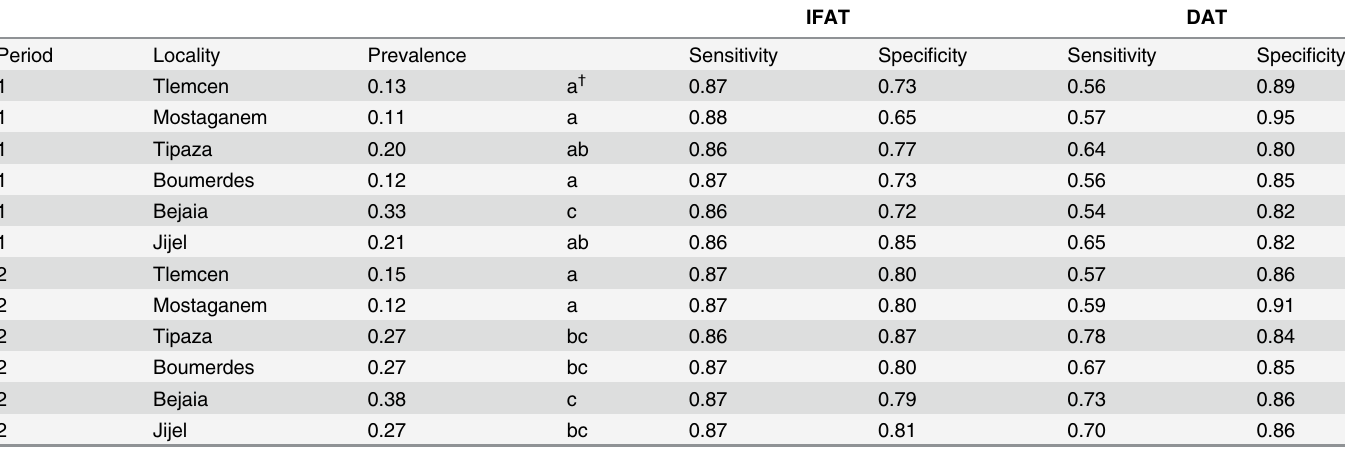
Table 6. Canine Leishmania infection true prevalence and diagnostic test characteristics estimated from the full conditional dependence model. IFAT